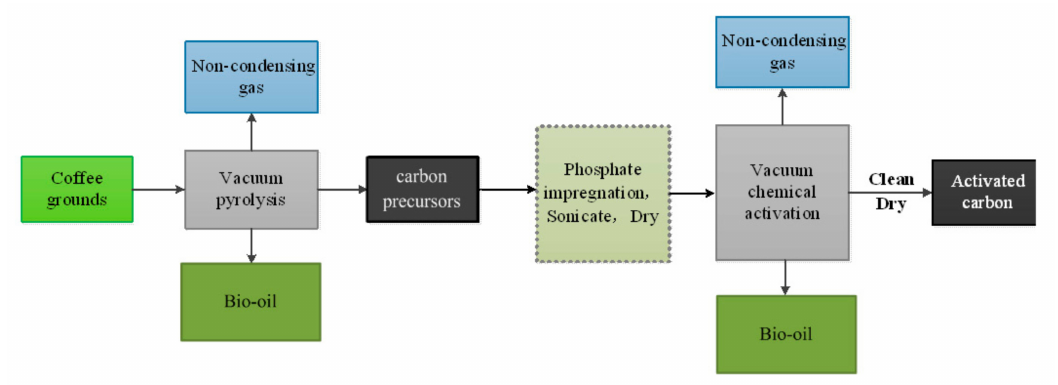
Figure 1. Refining